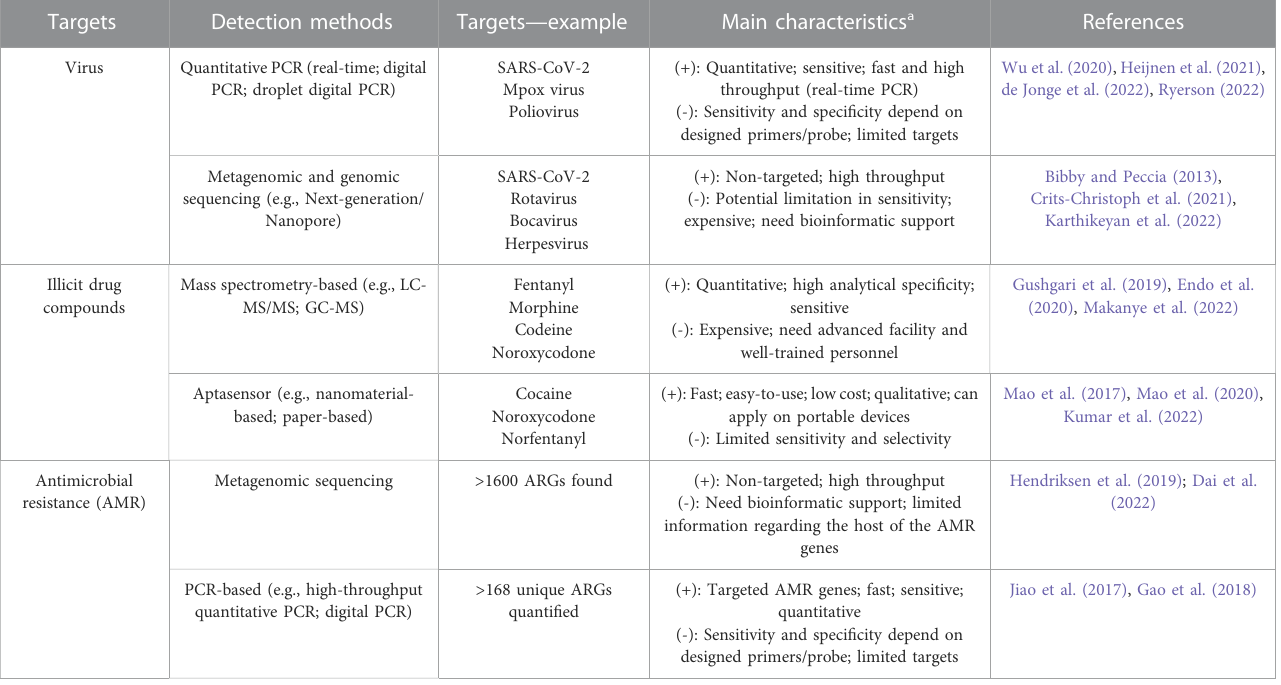
TABLE 1 Main methods for the detection of viral diseases, illicit drugs, and antimicrobial resistance in wastewater.